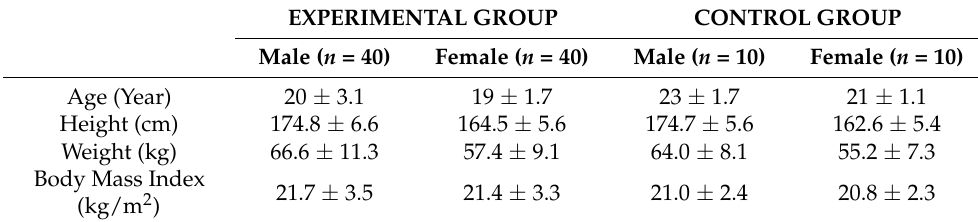
Table 1. Participant characteristics ( n = 100, mean ±